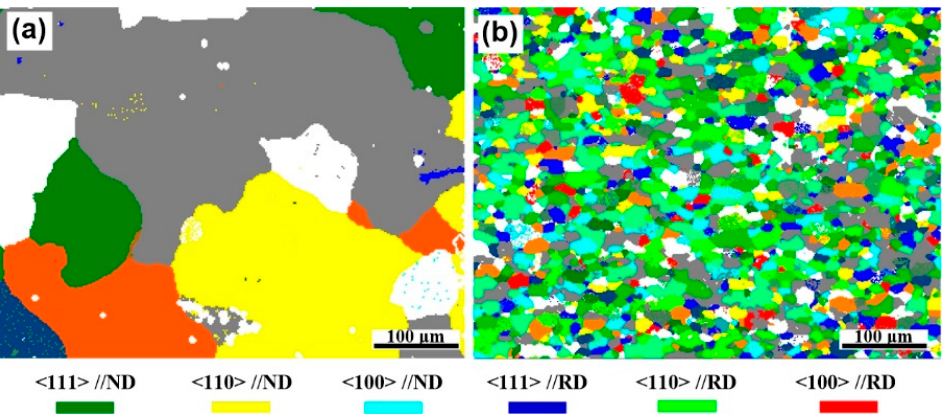
Figure 6. Crystal orientation distribution diagrams of ( a ) AA2219 alloy and ( b ) 5 wt.% nanosized TiB 2 /AA2219 composite. Table 2. Textures content of AA2219 alloy and 5 wt.% nanosized TiB 2 /AA2219 composite.